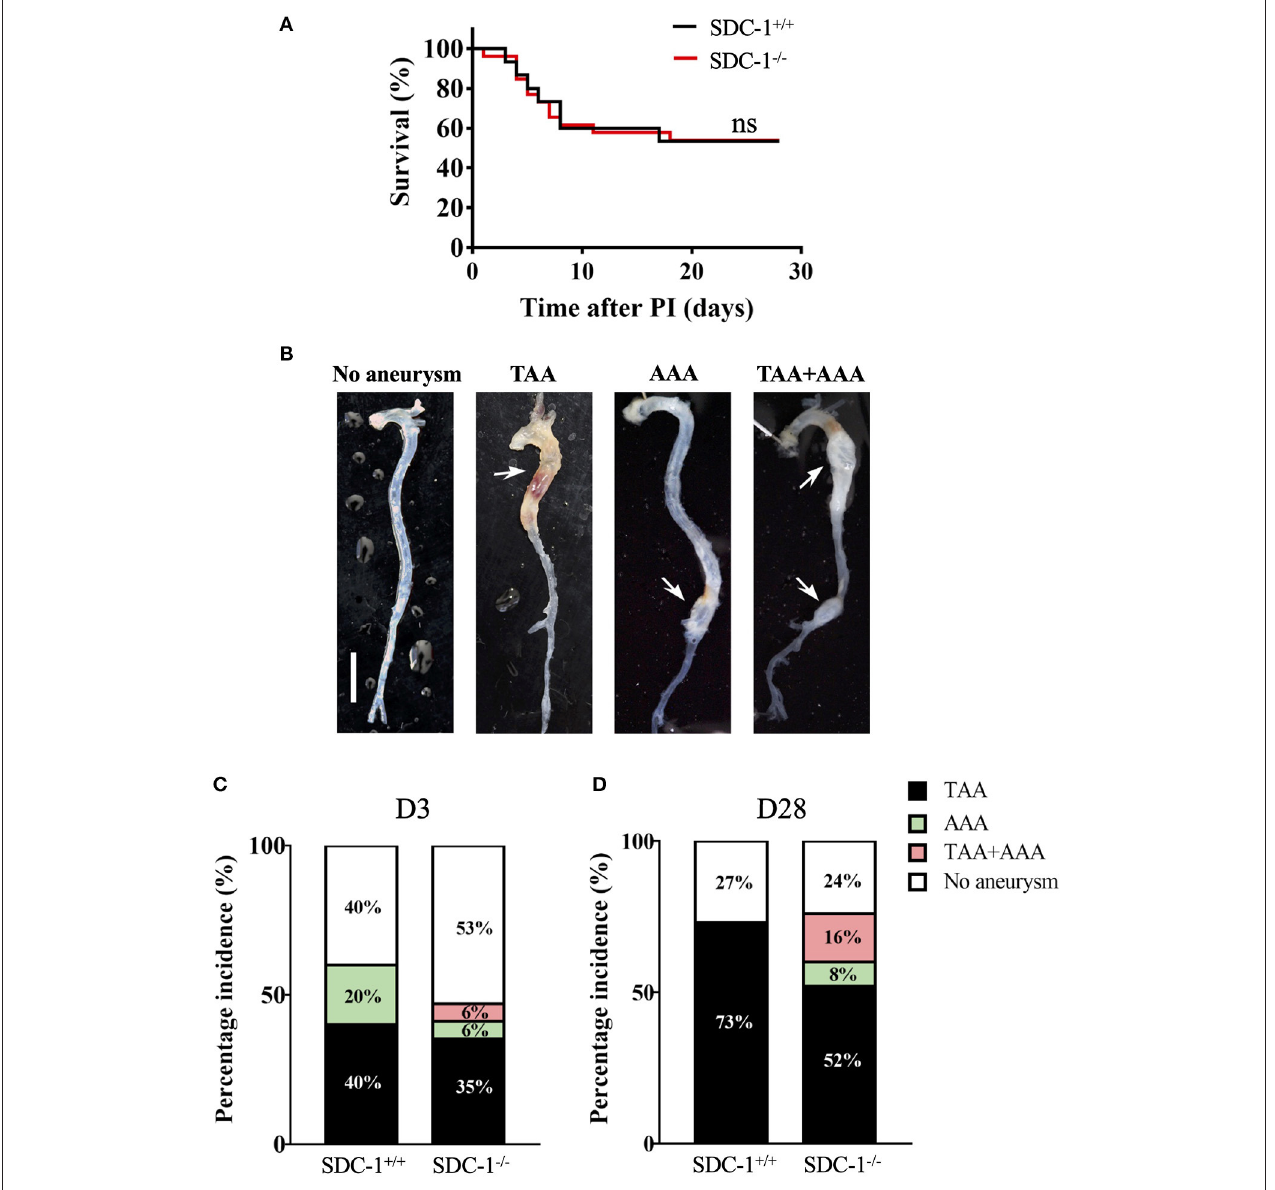
FIGURE 3 | SDC-1 is dispensable for TAA incidence or rupture but tends to protect from AAA development in mice. (A) Survival rate of mice after 28 days following Ang II infusion, compared with the Gehan-Breslow-Wilcoxon test. PI, pump implantation; SDC-1 + / + : n = 15, SDC-1 − / − : n = 26; ns, non-significant. (B) Aorta macroscopic images with/without aneurysms 28 days after Ang II infusion. Scale bar corresponds to 5mm. (C,D) Percentage of TAA or AAA incidence in SDC-1 + / + or SDC-1 − / − mice for 3 (C) or 28 days (D) of Ang II infusion. (C) SDC-1 + / + : n = 5, SDC-1 − / − : n = 17. (D) SDC-1 + / + : n = 15, SDC-1 − / − : n =